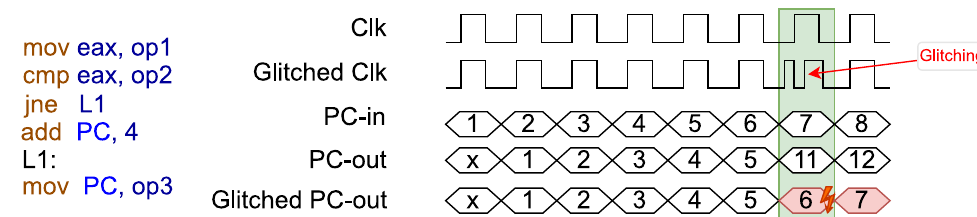
Figure 6. How clock glitching influence the branch address